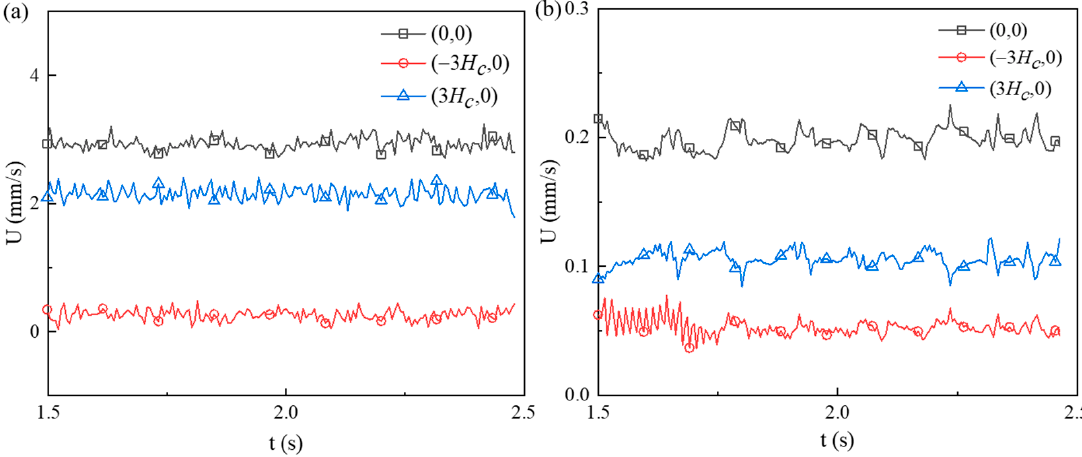
Figure 8. Velocity magnitudes at three different locations ( ( − 3 H c ,0 ) , ( 0,0 ) , ( 3 H c ,0 )) . ( a ) c p = 150 ppm and E app = 600 V/cm, ( b ) c p = 500 ppm and E app = 100 V/cm .